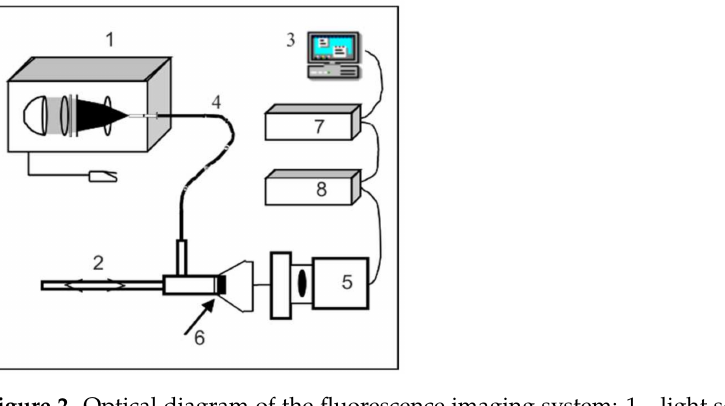
CCD camera GP-KS162 (Panasonic, Osaka, Japan), xenon lamp with liquid fiber 300 W